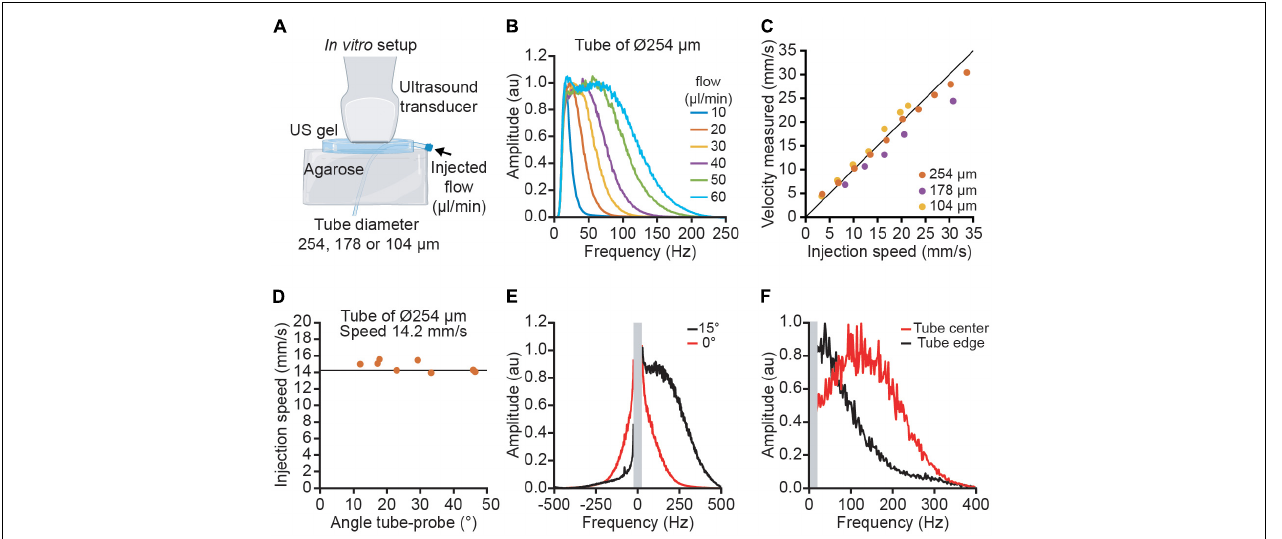
FIGURE 2 | Quantitative velocity measurement performed in vitro using polyimide tubes of various diameters. (A) The experimental set-up used blood mimicking fluid injected in 3 tubes of increasing diameter (104, 178, and 254 µ m) to simulate the variety of cortical vessels. (B) Average Doppler spectrum for different flows ranging from 10 to 60 µ l/min. (C) Measurement of velocities using ultrasound imaging for the three tubes (yellow: 104 µ m, purple: 178 µ m, orange: 254 µ m). (D) Example of the velocity measured at different angles ranging from 10 to 45 ◦ for the tube of 254 µ m diameter. The vertical line corresponds to the actual speed of the particles (14.2 mm/s). (E) Effect of the spectral broadening. Due to the spectral broadening, a horizontal tube (angle 0 in red) has a positive and negative spectrum. With an angle of 15 ◦ , the Doppler effect is higher than the spectral broadening and the spectrum is lateralized. (F) Effect of the laminar flow profile. The spectrum in the center of the tube (red) has a higher frequency than in the edge